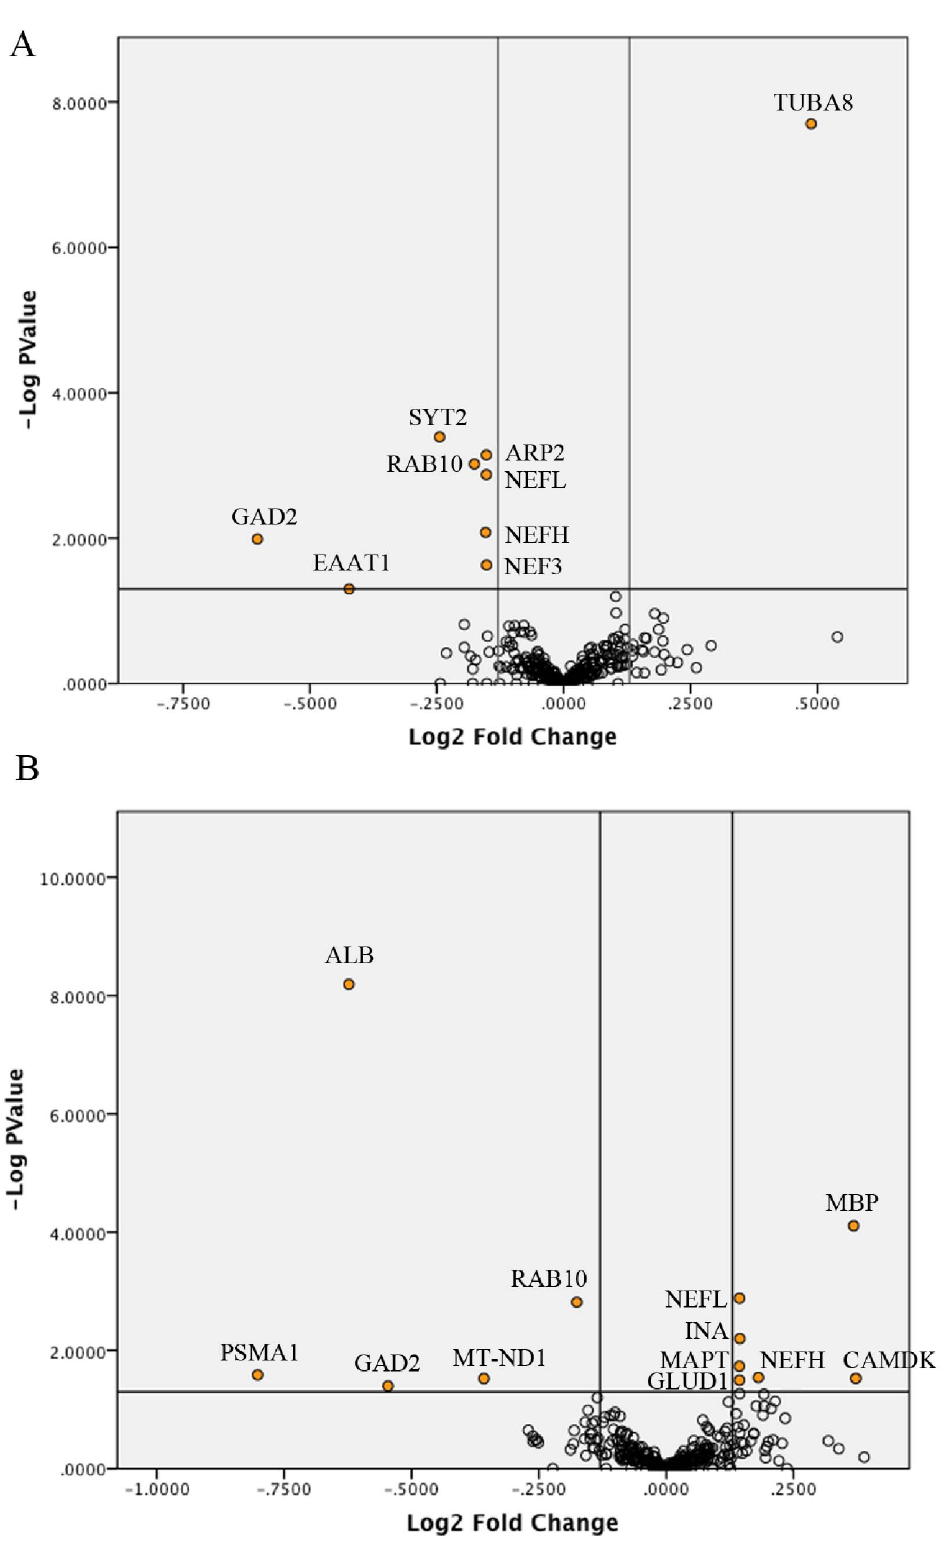
Figure 4. Volcano plots showing the distribution of significance and fold change of identified proteins in the (A) sham + rt-PA/sham comparison and (B) tMCAo + rt-PA/tMCAo comparison. All proteins with 2 or more peptides were plotted with fold change on the x-axis and p- value on the y-axis. Vertical lines mark a fold change of + / 2 10% and the horizontal line marks p =0.05. The 18 proteins marked in orange with text labels meet the criteria for having differential expression ( . 10% in either direction) and are significant ( , p=0.05).